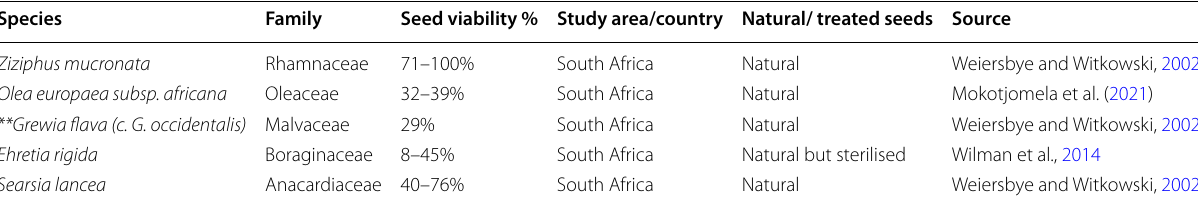
Seed treatment and source of information are provided (** viability of another Grewia species was used)